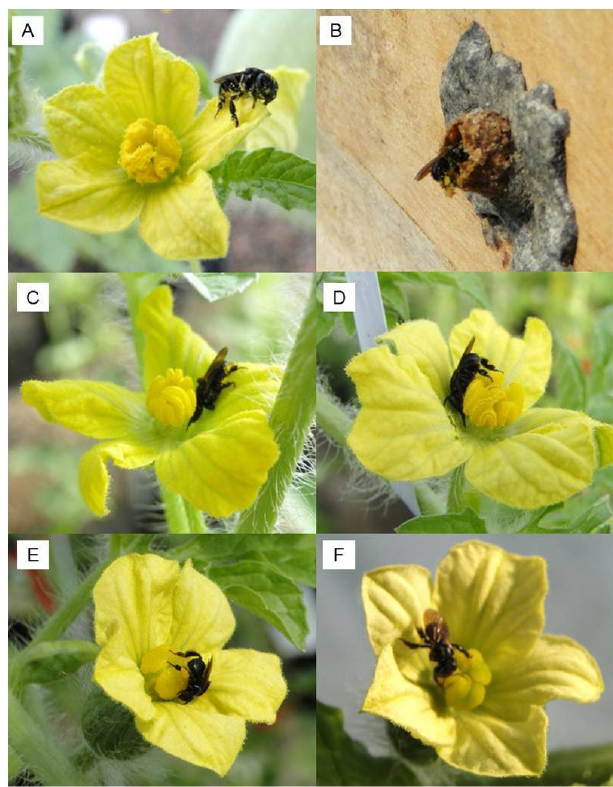
Fig 4 . Foraging behavior of Scaptotrigona sp. nov.workers in mini watermelon ( Citrullus lanatus ) flowers grown in a greenhouse. A - Worker covered with pollen grains and stopping on a petal of a staminate flower while brushing herself before taking off. B - Forager returning to the nest with pollen on her cobiculae. C - Worker collecting nectar while on a staminate flower and touching the anthers with her head and dorsal part of the thorax. D - Forager collects nectar while sitting on the anthers of a staminate flower, acquiring pollen on her ventral parts of the thorax and abdomen. E - Worker with pollen on her corbiculae, while moving over the stigma of a pistillate flower in a search for nectar. F - Forager moving from the petal to the stigma of a pistillate